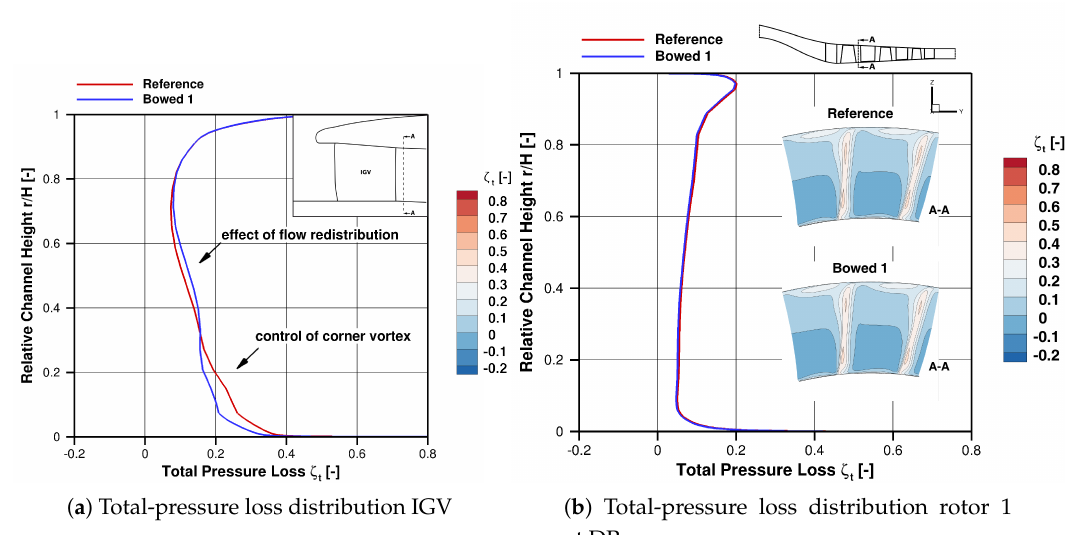
Figure 15. Effect of sweep and